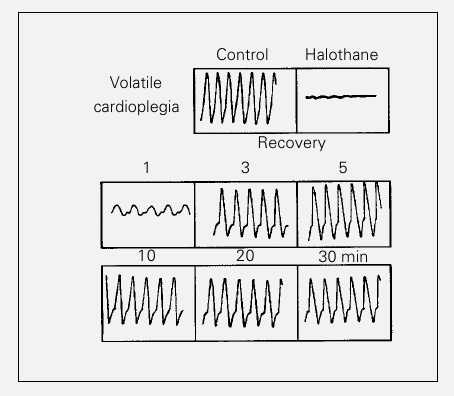
Figure 1 - Force and heart rate variation of isolated perfused rat heart during halothane cardiople- gia and recovery (1-30 min) (rat No.